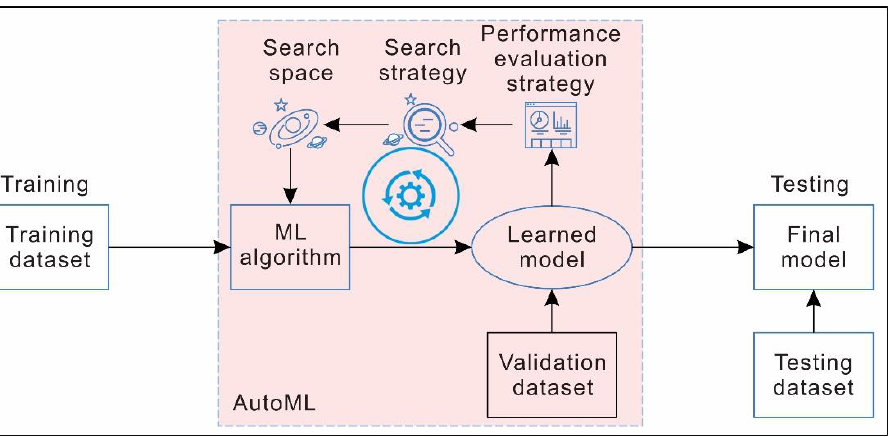
Figure 4. Schematic diagram showing the workflow of AutoML.